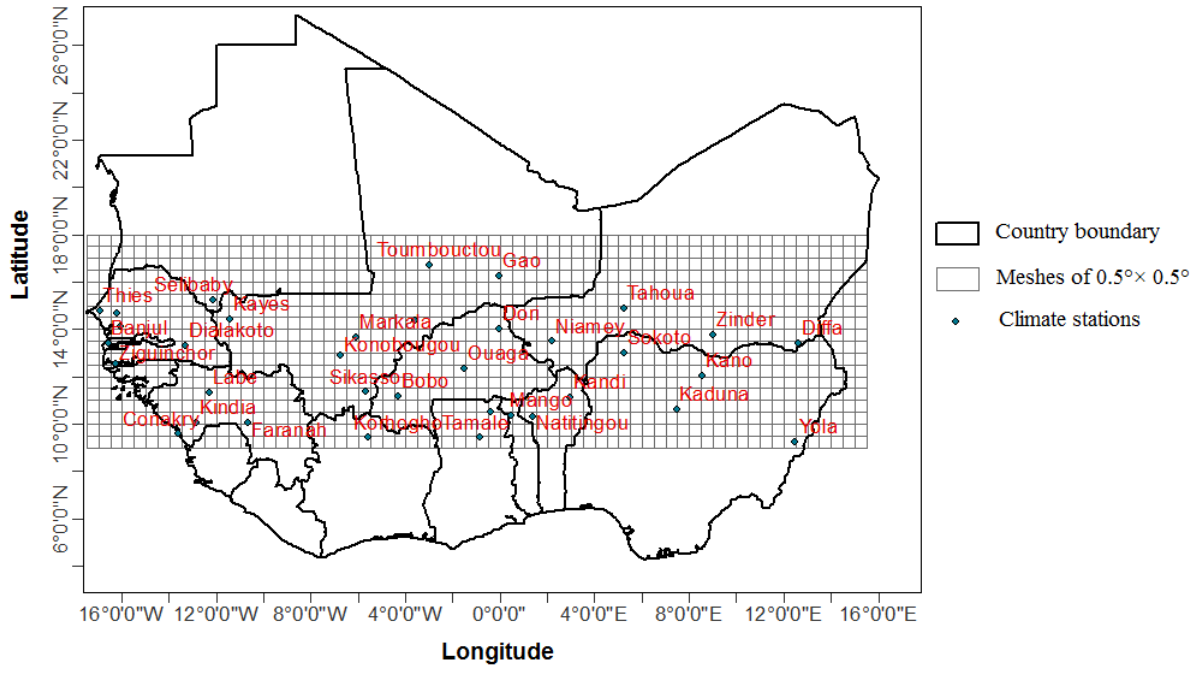
Figure 1. West African Sudano-Sahelian zone and the grids coverage.